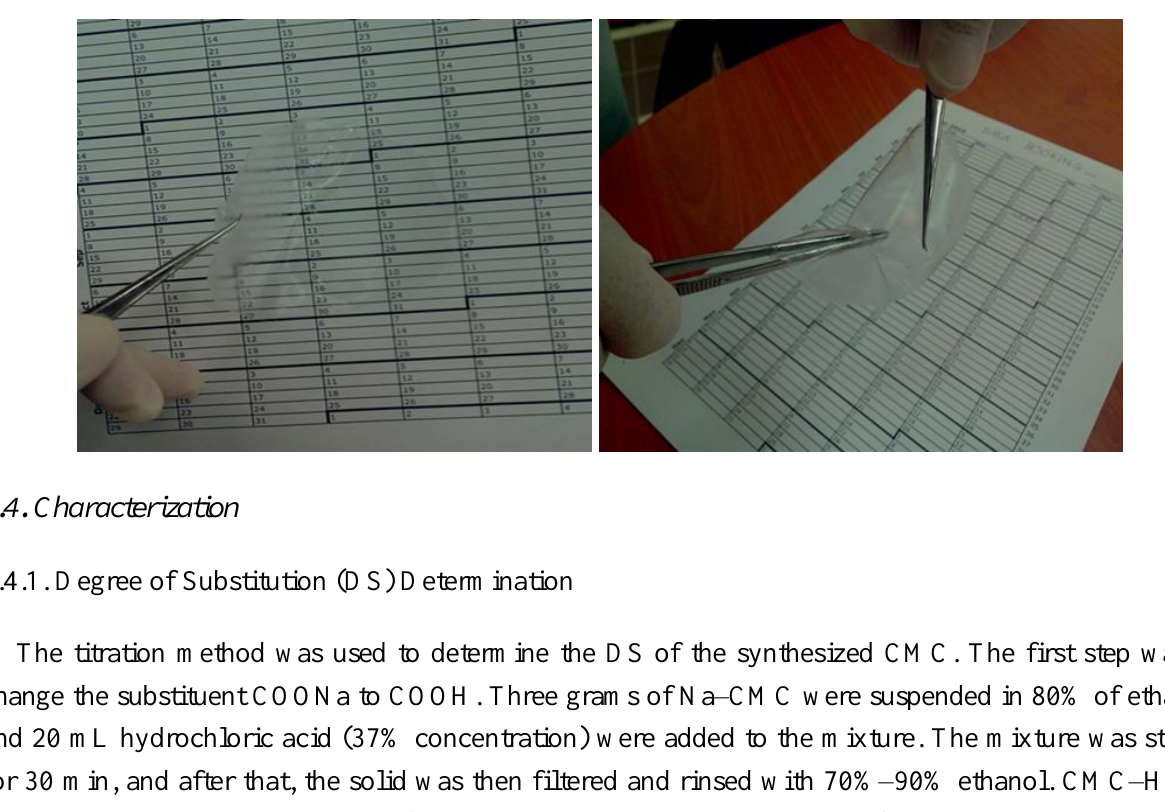
COONH biopolymer electrolyte 3 4